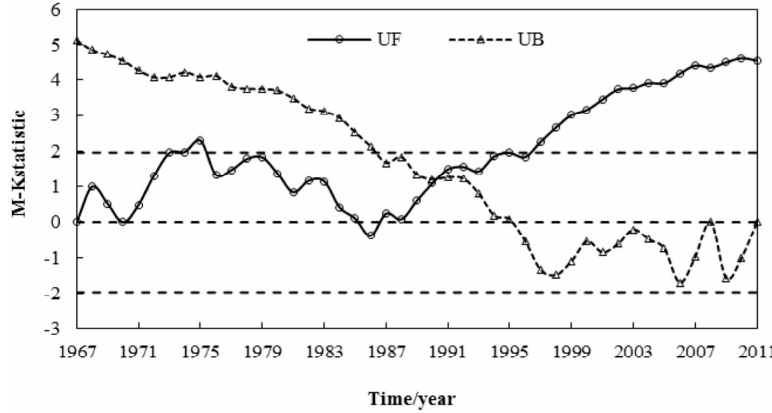
Figure 3. The M–K test for average annual temperature in the Lanhe Watershed.